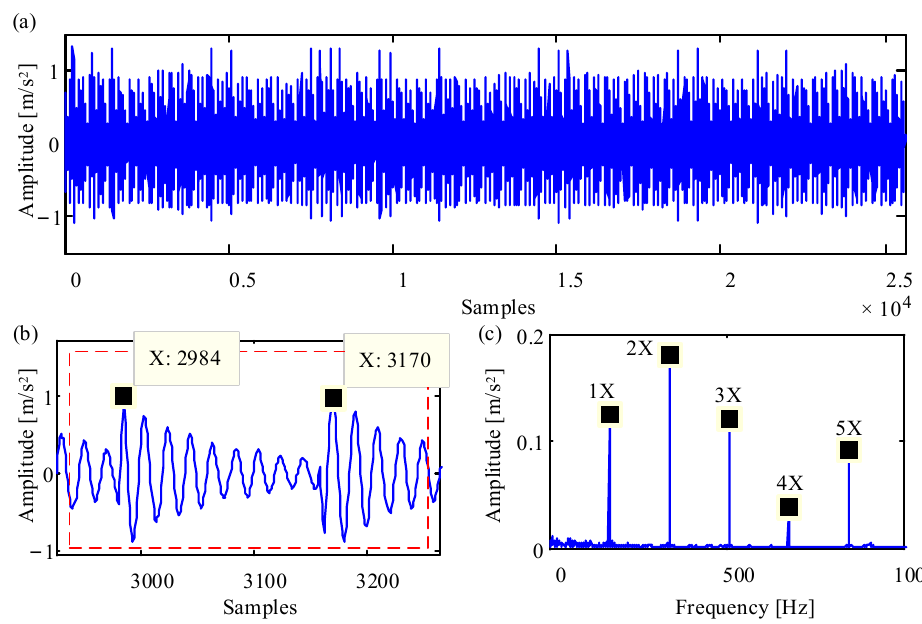
Figure 7. The results of simulated analysis at 1000 rpm: ( a ) raw signal; ( b ) the local signal of ( a ); ( c ) envelope spectrum.